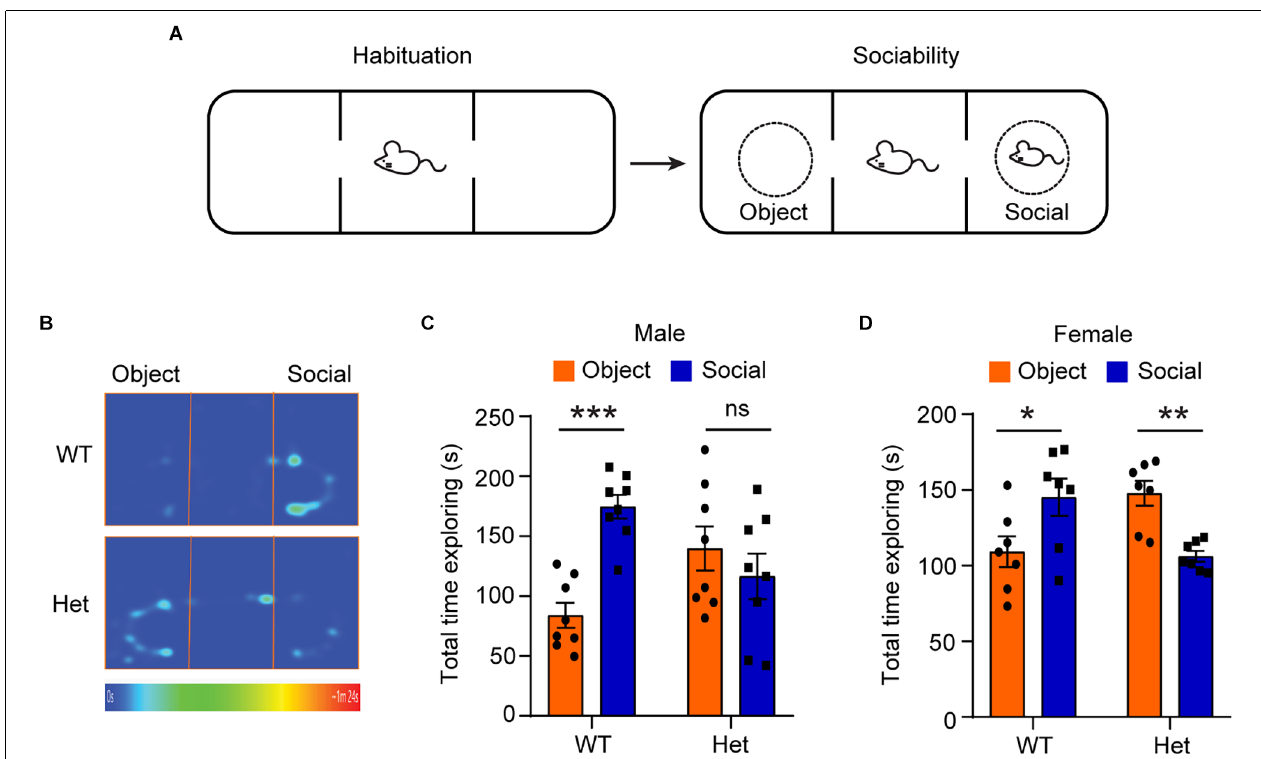
FIGURE 1 | Heterozygous Kdm6b knockout mice display impaired sociability. (A) Diagram showing the experimental procedure for the sociability test. (B) Representative heatmap showing the time that wild-type and heterozygote Kdm6b -KO mice spent in exploring the social partner and the non-social object. (C) Quantitative results showing the time that male wild-type and heterozygote Kdm6b -KO mice spent exploring their social partner and object. n = 8 per genotype. P-value calculated using two-way ANOVA test and Sidak’s multiple comparisons test. For the Sidak’s multiple comparisons test: *** p < 0.001, ns: not significant. Error bars in graphs represent mean ± SEM. (D) Quantitative results showing the time that female wild-type and heterozygote Kdm6b -KO mice spent exploring their social partner and object. n = 7 per genotype. P-value calculated using two-way ANOVA test and Sidak’s multiple comparisons test. For the Sidak’s multiple comparisons test: * p < 0.05; ** p < 0.01. Error bars in graphs represent mean ±